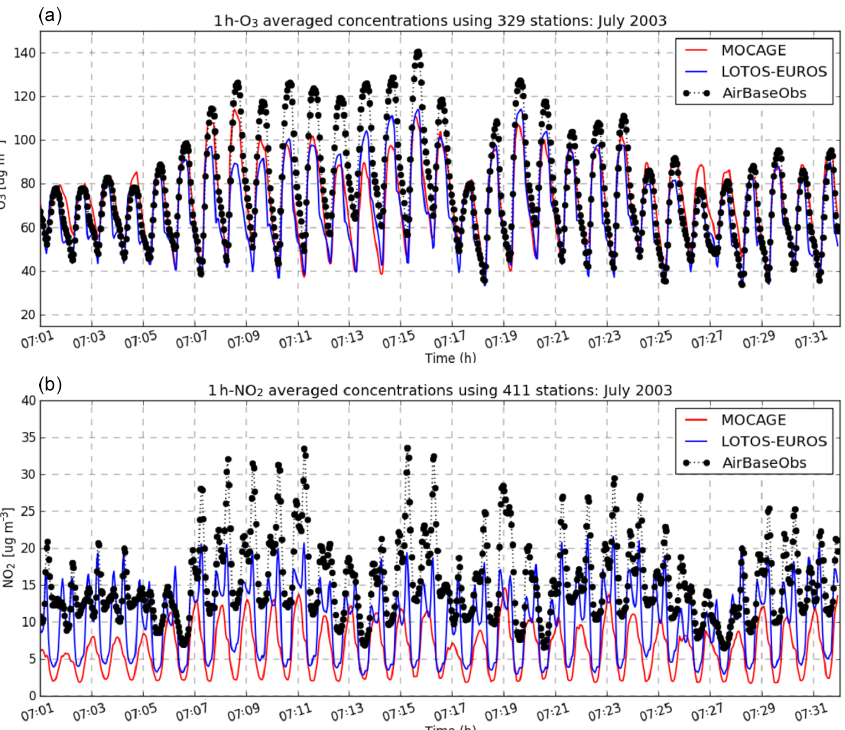
Figure 7. Time series of ozone (a) and NO 2 (b) concentration from NR (red, MOCAGE), CR (blue, LOTOS-EUROS) and AirBase back- ground observations (black dots) for the period of July 2003.